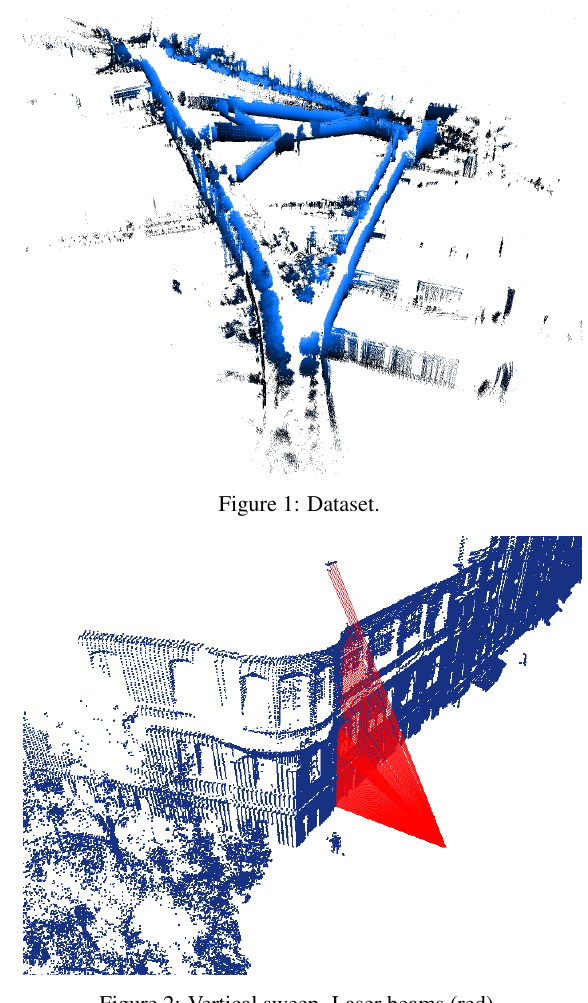
Figure 2: Vertical sweep. Laser beams